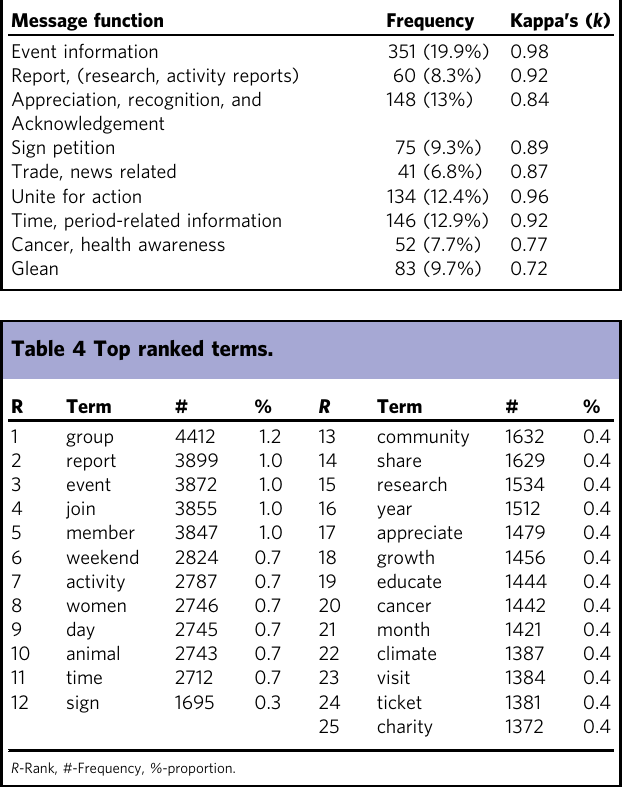
Table 3 Coding scheme, frequencies, and coder reliabilities. Message function